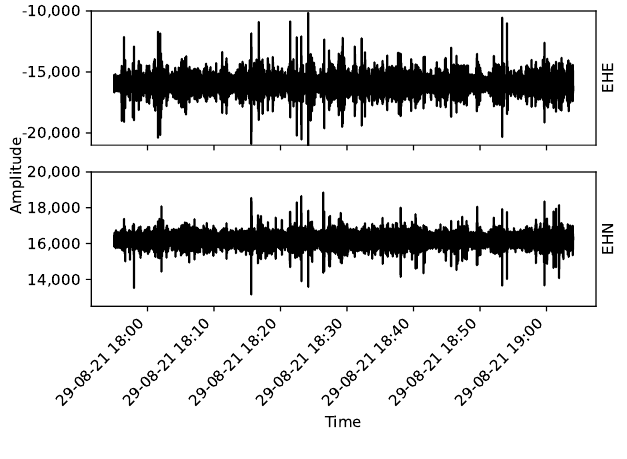
( b ) Heterogeneous Dam without Water Flow for Sensor AM.R7D9F.